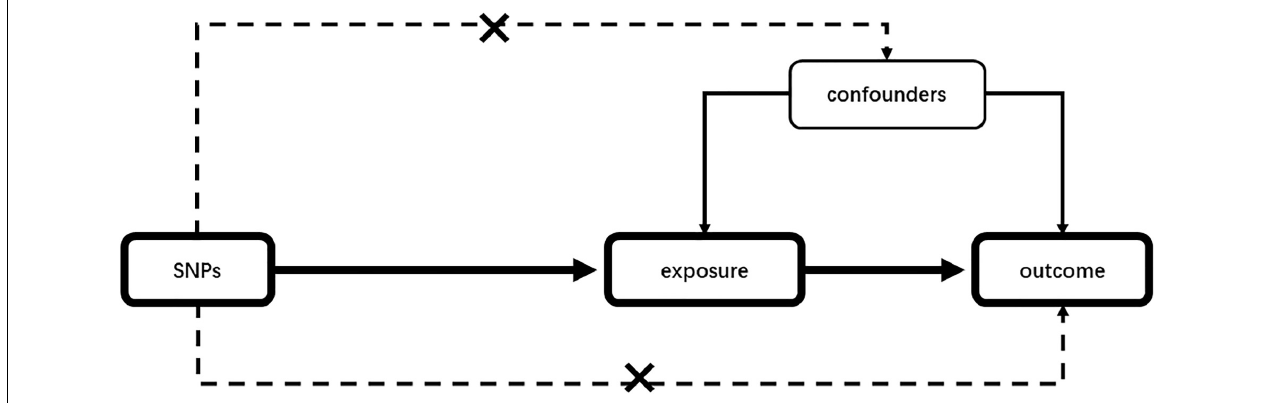
FIGURE 1 | Mendelian randomization analysis schematic diagram. Our study aims to estimate the causal relationship between risk factors and outcomes using SNPs as instrumental variables. SNPs should not be associated with any confounding factors. SNP, single-nucleotide